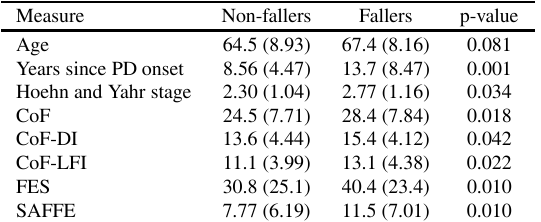
Table 1C Table 2 Survey of Activities and Fear of Falling in the Elderly (SAFFE) Mean (SD) values for fallers and non-fallers on measures of fear of falling CoF: Consequences of Falling Scale; CoF-DI: Consequences Scale: Percentage of the sample who sometimes or always avoided of Falling, damage to identity; CoF-LFI: Consequences of Falling, each activity. Valid N ranged from 113 to 119 loss of functional independence; FES: Falls Ef fi cacy Scale, SAFFE: Activity Survey of Activities and Fear of Falling in the Elderly. Signi fi cance for FES is based on tests of logged FES